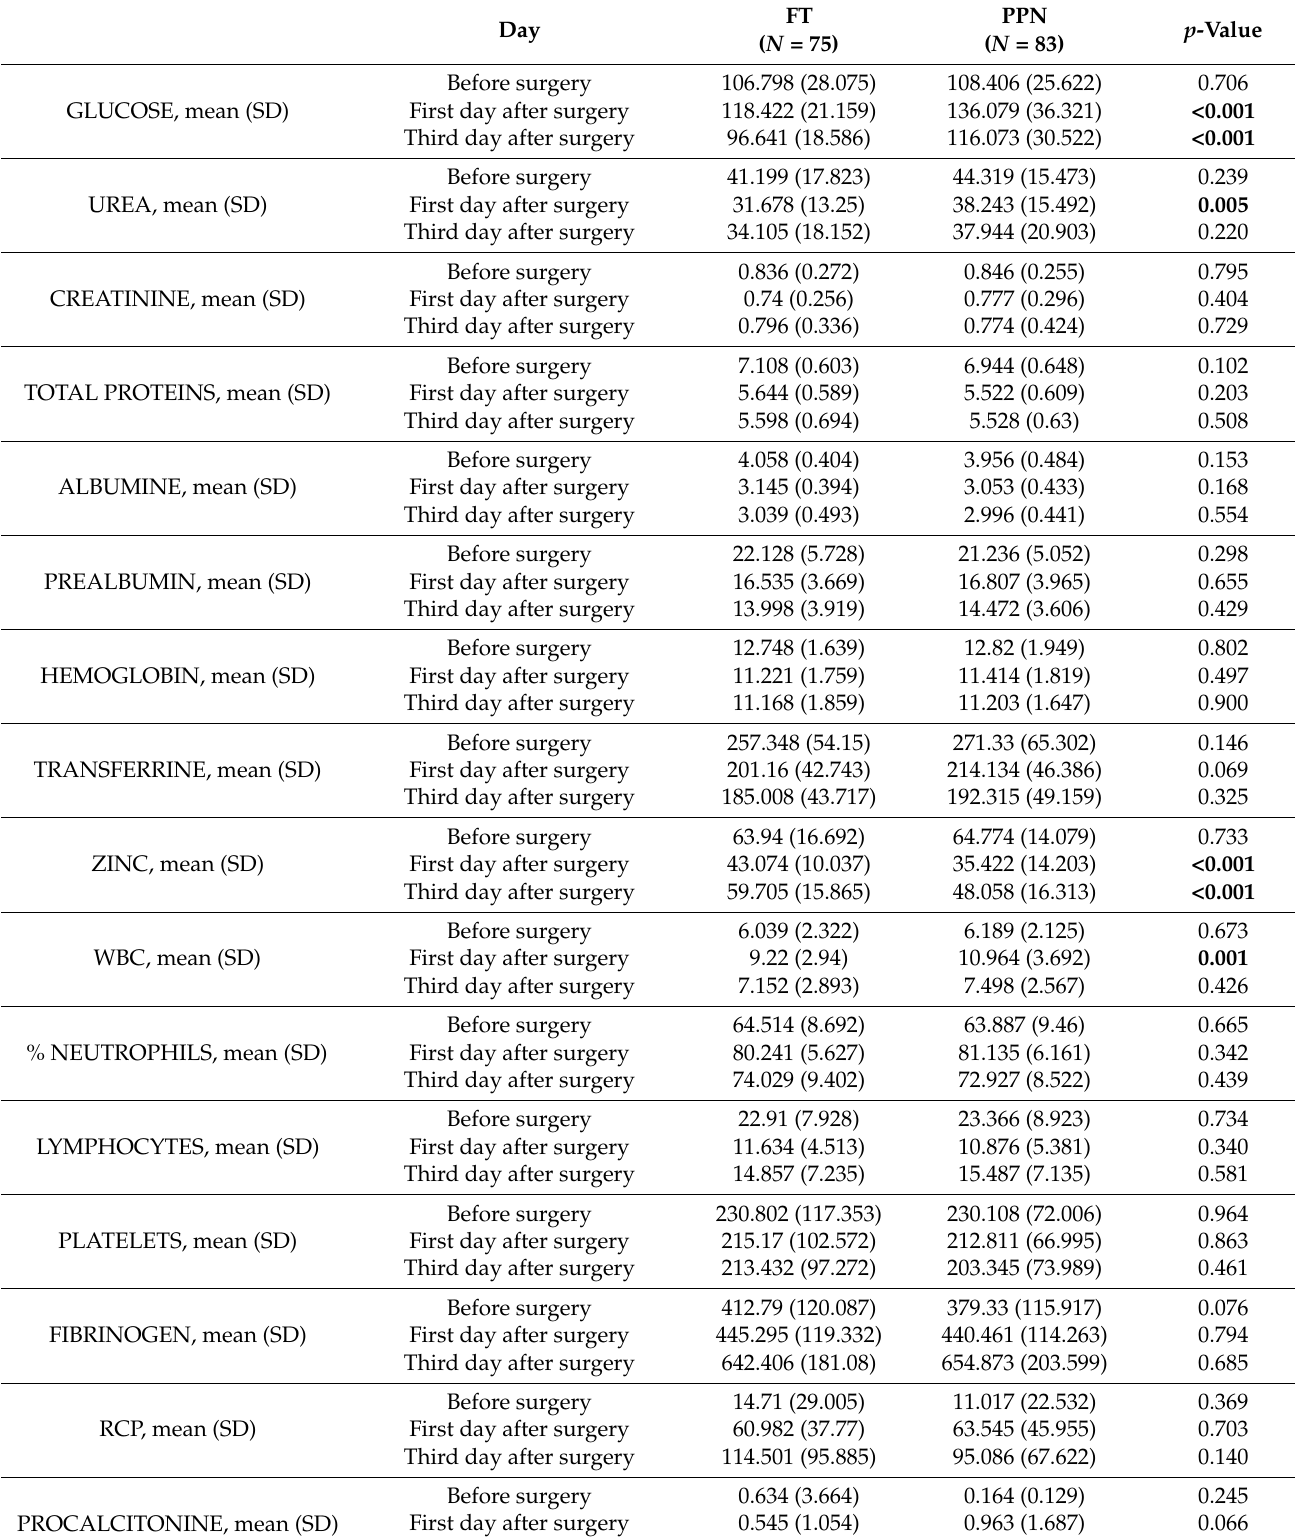
Table 2. Values of the parameters analyzed before and after